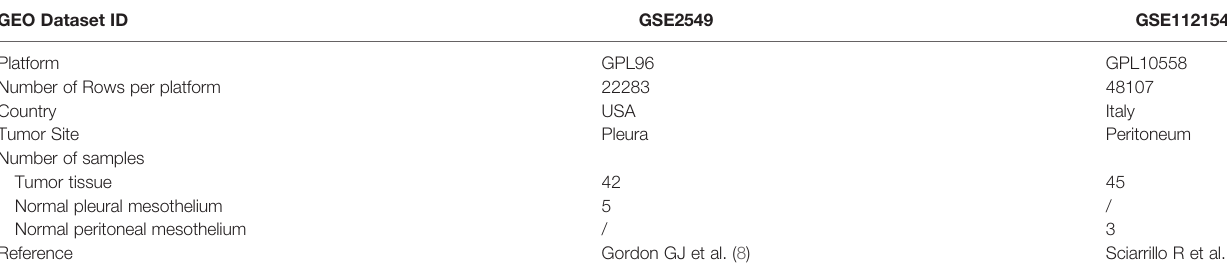
TABLE 1 | Characteristics of the included